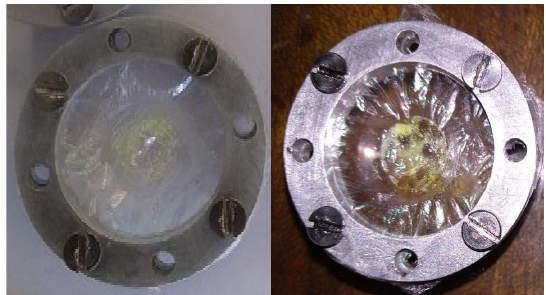
Fig. 1. 1 mg of Natural Sulfur deposited over a disk of 1 cm diameter. Left: target before irradiation, Right: target after 2 continuous days of irradiation with E lab = 3 MeV, I b = 6 nA proton beam.